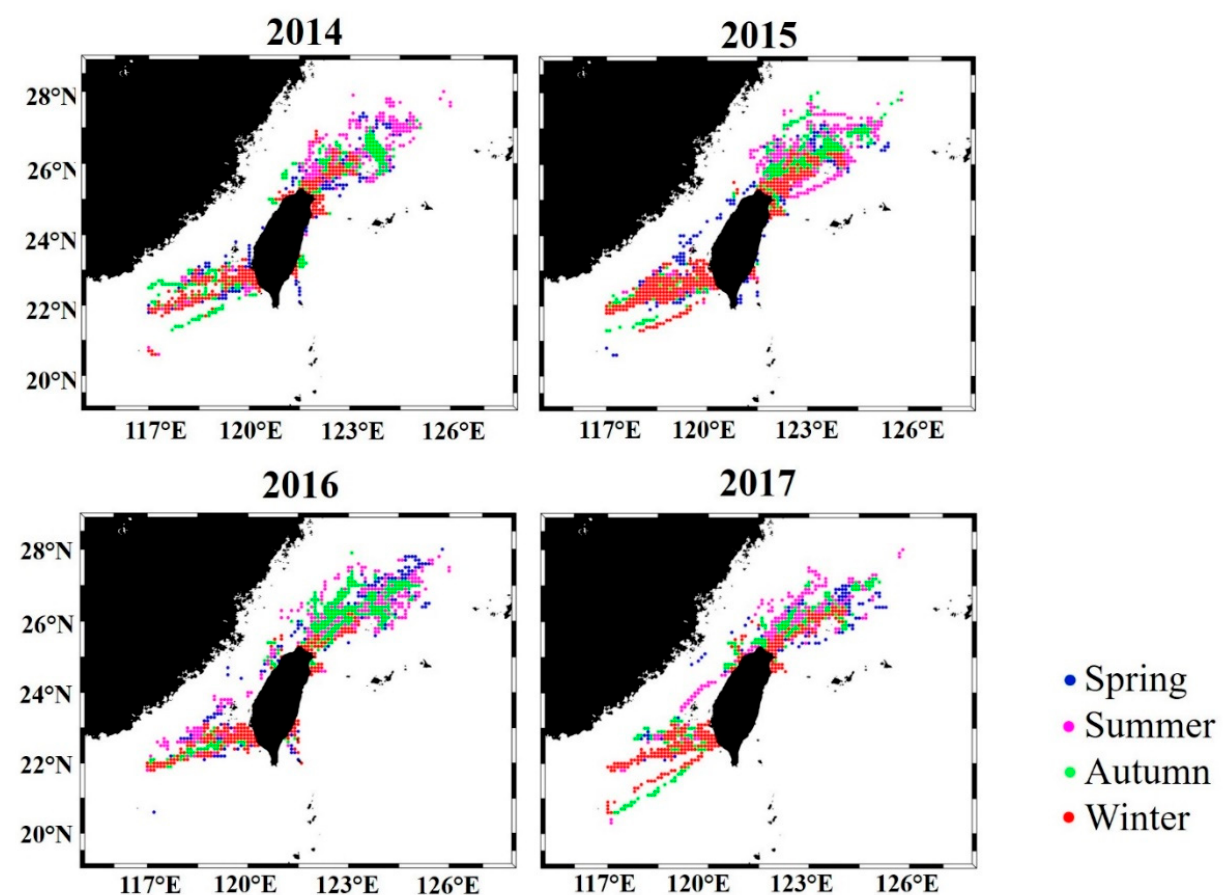
Figure 2. Seasonal variations and distribution patterns of the fishing locations (in 0.1 spatial grids) of greater amberjack from 2014 to 2017 in the TS.